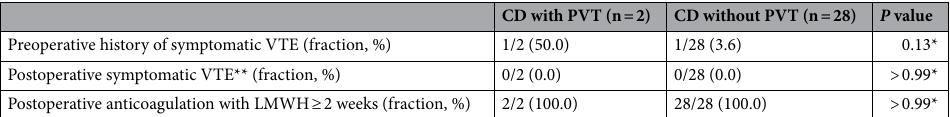
CD with PVT (n = 2) CD without PVT (n = 28) P